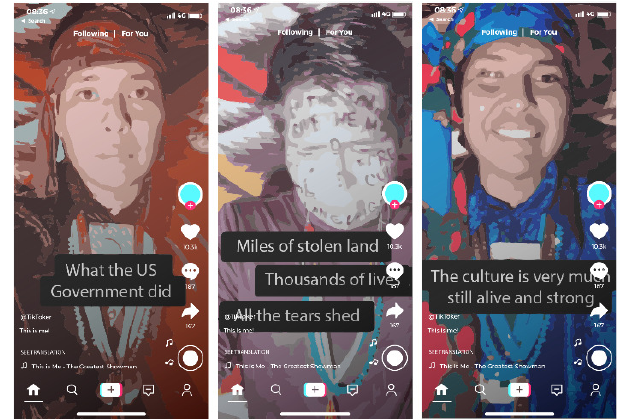
Figure 5. Illustrated TikTok post about colonialism and tradition.